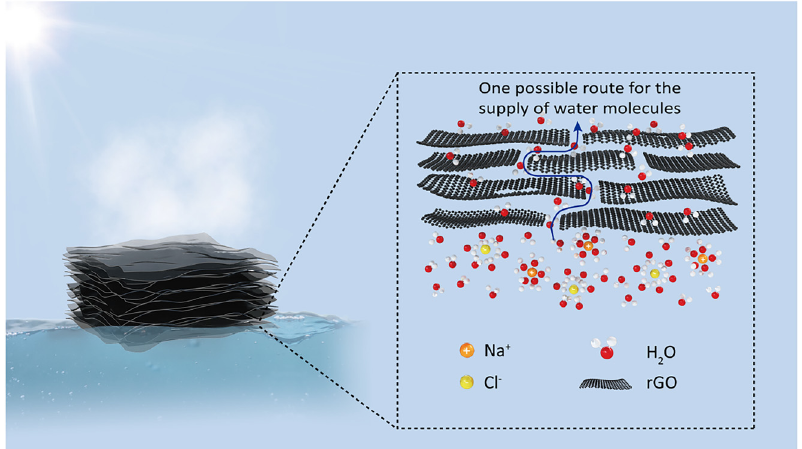
Figure 1: Schematic and mechanism of the salt-rejecting solar desalination process by the free-standing reduced graphene oxide (rGO) membrane. The blue arrow denotes one possible route for the supply of water